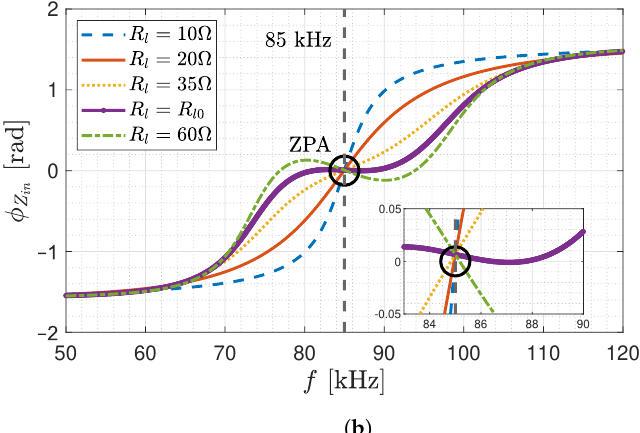
Figure 4. ( a ) Voltage gain magnitude and ( b ) input impedance angle as a function of the frequency for the inductive link designed for working with CV operations at f 0 = 85 kHz.